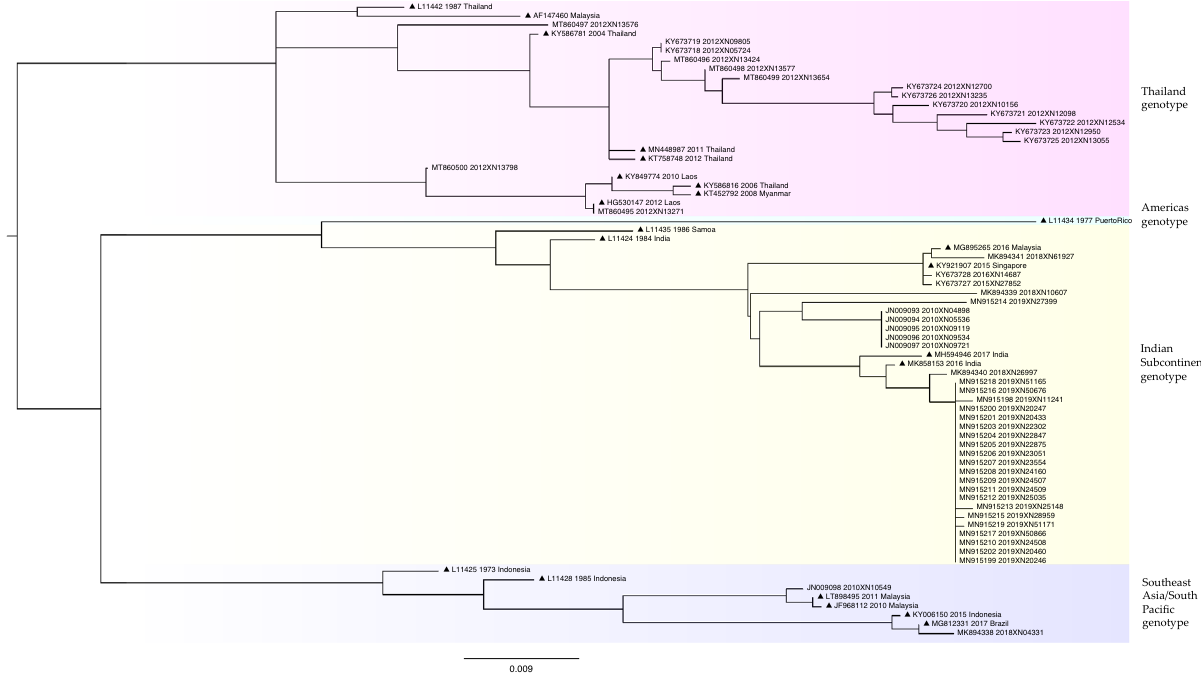
Figure 4. Phylogenetic tree of DENV3 E gene sequences. The reference sequences are indicated with black triangles, for clarity, with the accession number, and year and country of isolation. Sequences detected in Guangzhou between 2010 and 2019 are indicated with the accession number, year of isolation, and the laboratory